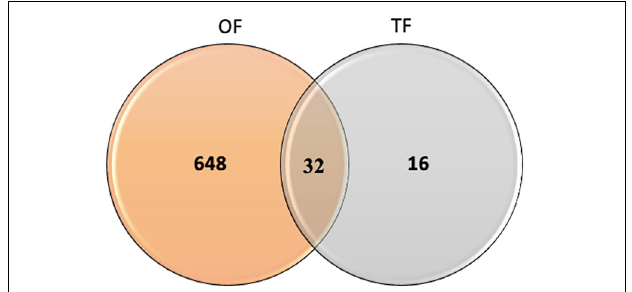
FIGURE 5 | Venn diagram displaying the specific features of proteins identified in the Oval vs. Fusiform (OF) and Triradiate vs. Fusiform (TF) pairwise comparisons. Thirty-two proteins were overlapping between the OF and TF comparisons. Six hundred and forty-eight and 16 proteins were specifically expressed in oval and triradiate morphotypes respectively. Venn diagram analysis was achieved using the 680 proteins subset identified in the OF pairwise comparison and the 48 proteins identified for the TF pairwise comparison ( p -value ≤